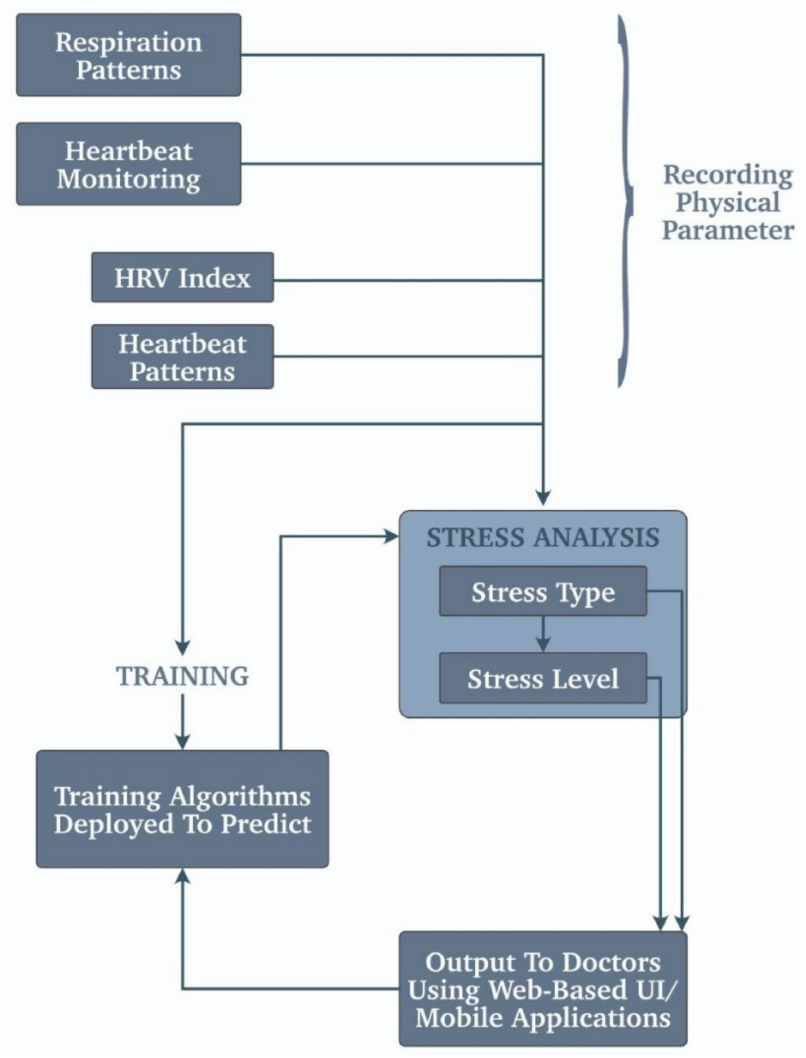
Figure 11. Stress monitoring